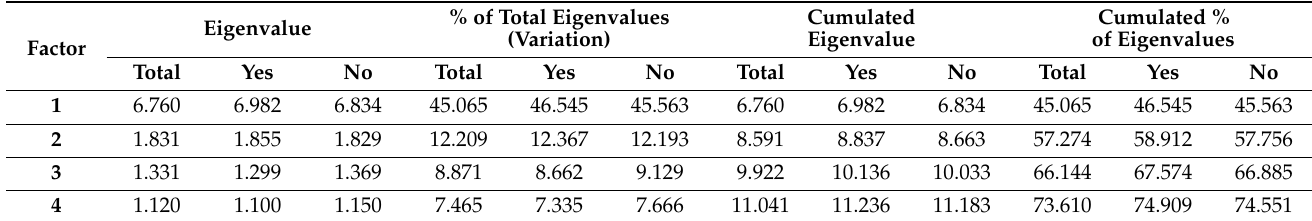
Table 5. Hierarchy of factors according to their eigenvalues based on the Kaiser